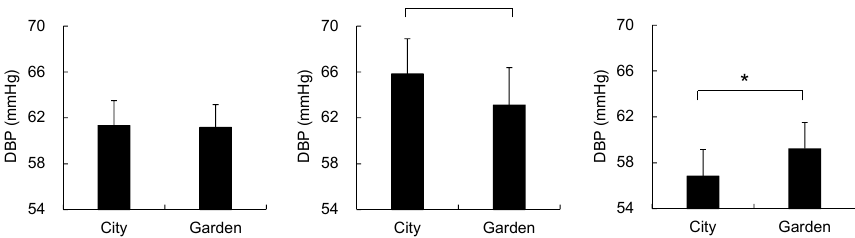
Figure 4. Comparison of the diastolic blood pressure (DBP) between city and garden landscapes in all ( left ), male ( middle ), and female ( right ) participants. Mean ± standard error; Total N = 18; Male N = 9, Female N = 9; * p < 0.05.